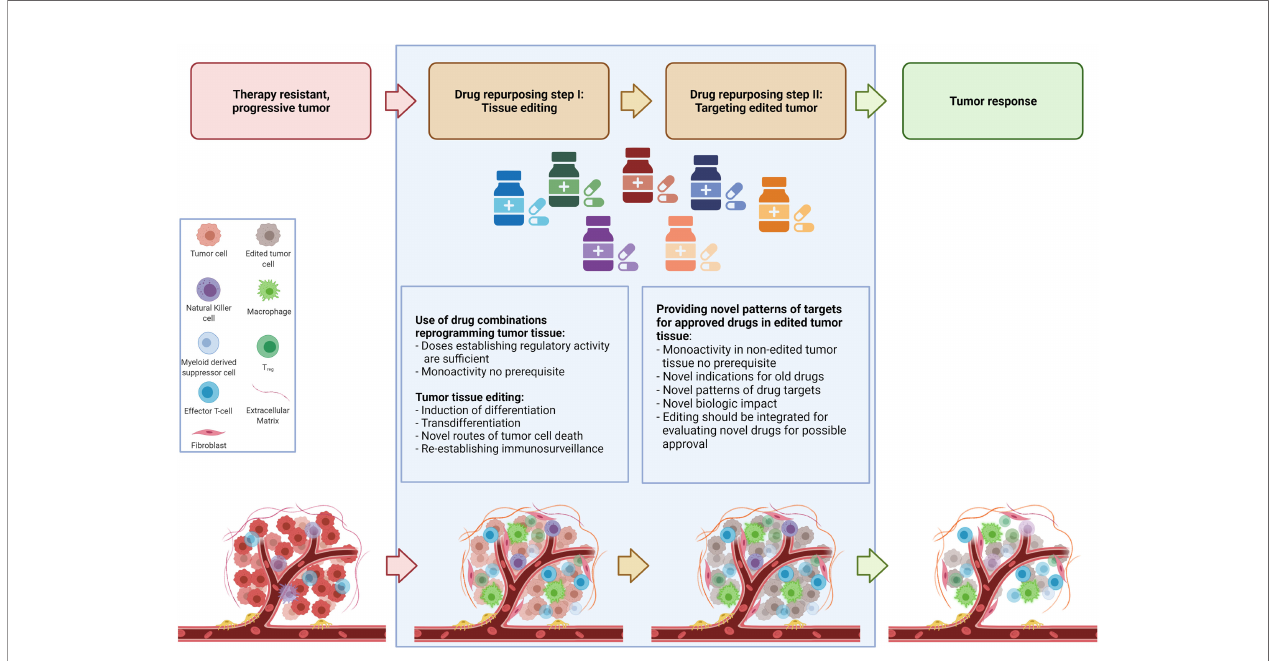
FIGURE 1 | Establishing novel system states for tumor control in a two-step drug repurposing